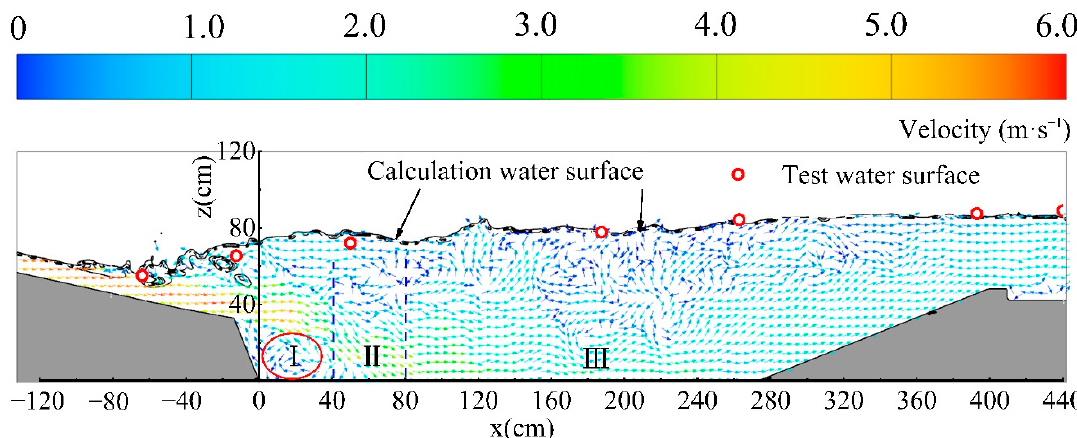
Figure 6. Numerical simulation of water surface profile and x-z plane flow rate vector.